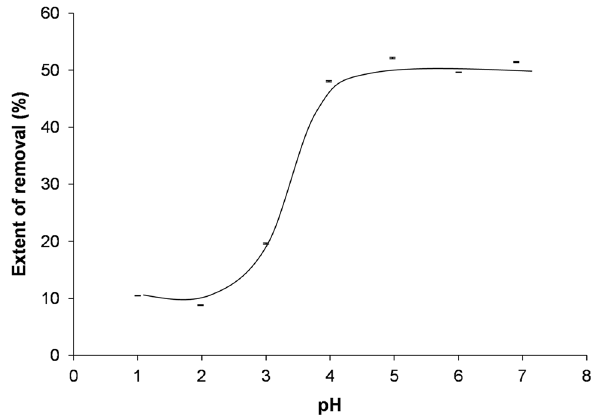
Fig. 4 Variation of extent of removal of Ni(II) with a thermal treatment time by biosorbent prepared at 125 °C and b treatment temperature of the biosorbent (0.100 g peel, 10.0 mg L −1 of 50.0 mL solution, 120 min shaking time, 30 min settling time, ambient pH of